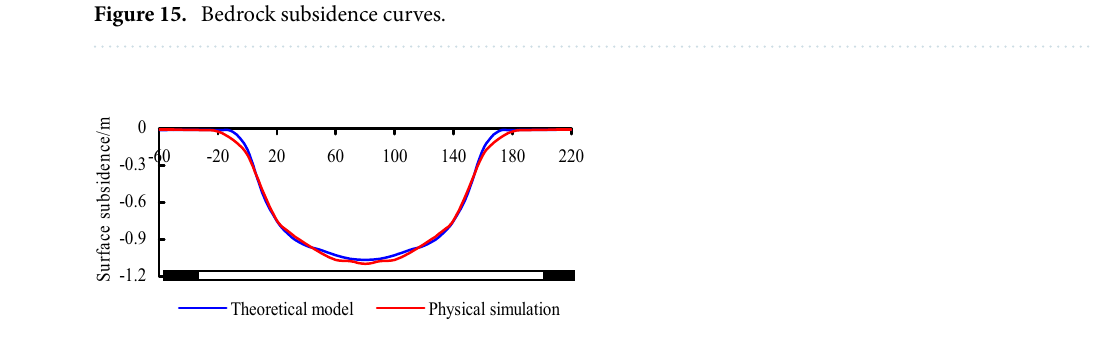
Figure 16. Surface subsidence curves.